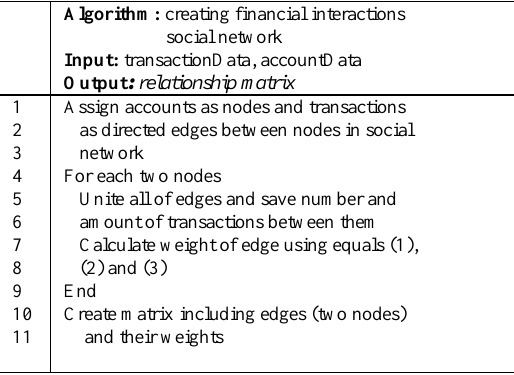
Figure 3. Pseudo-code for creating financial interactions social network phase in the proposed CAA